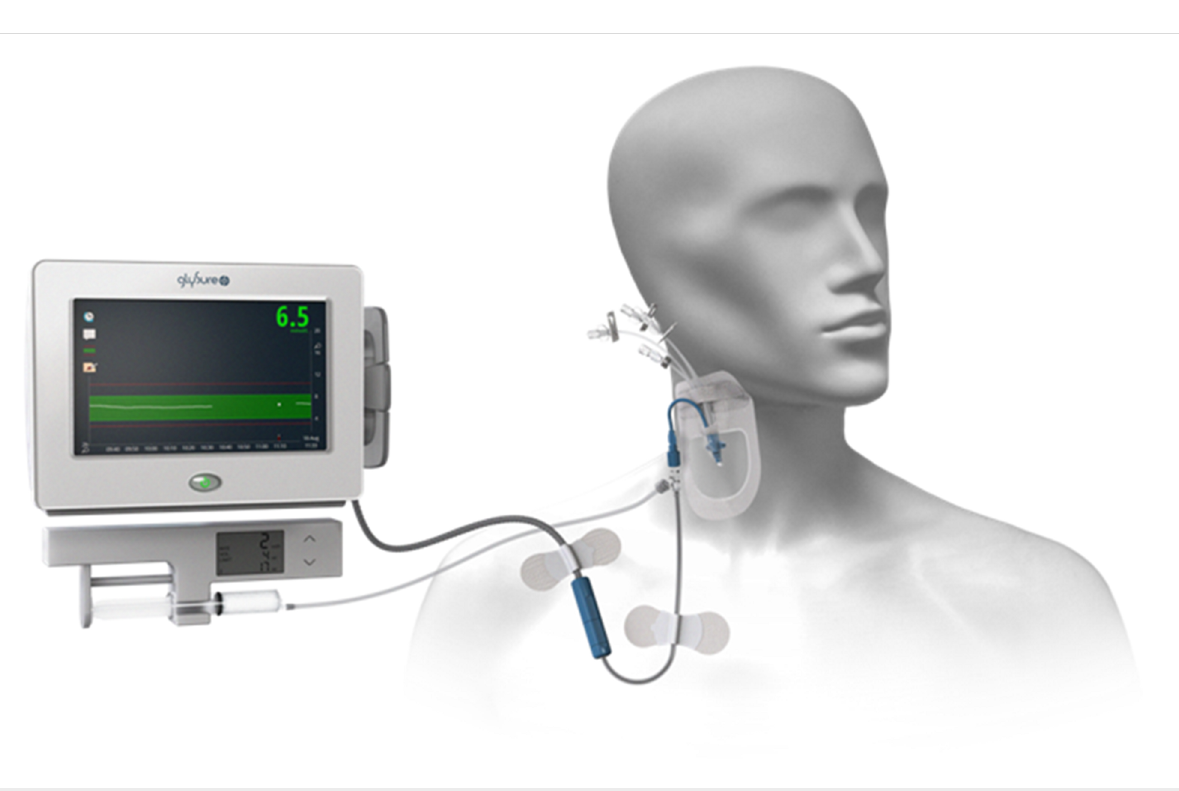
Figure 8: Glysure Continuous Intravascular Glucose Monitoring (CIGM) System. Image provided by Nicholas P. Barwell Glysure Ltd.